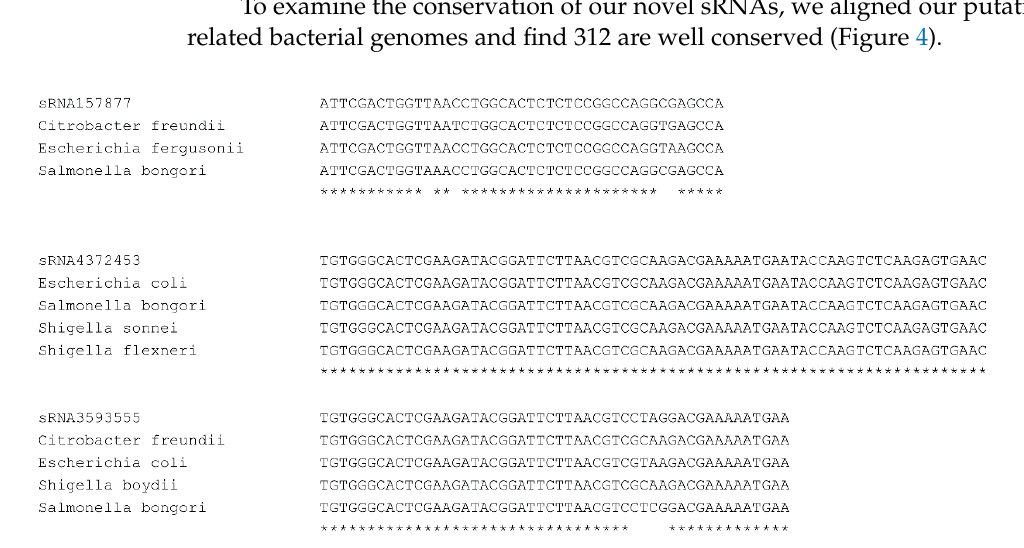
Figure 4. ClustalW alignments of novel sRNAs with conserved loci. ( Top ) sRNA157877 ( Middle ) sRNA4372453 ( Bottom ) sRNA3593555. *, 100% nucleotide identity.